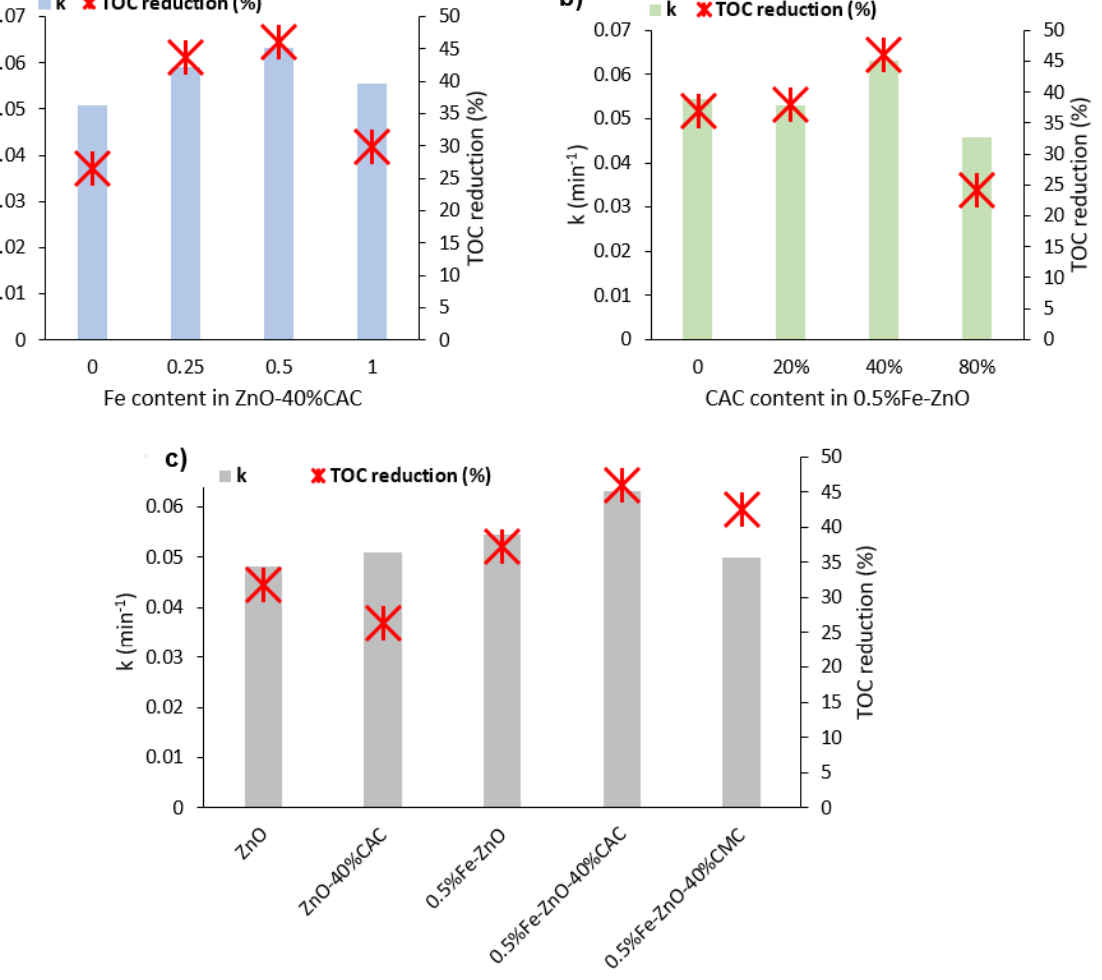
Figure 8. Comparison of degradation rate and mineralization of ibuprofen in the presence of different types of photocatalyst depending on ( a ) the Fe content in ZnO-40%CAC, ( b ) CAC content in 0.5%Fe-ZnO, ( c ) modification by 0.5%Fe and/or 40%CAC or 40%CMC of ZnO. Experimental conditions: IBU initial conc.: 20 mg dm − 3 , V = 15 cm 3 , photocatalyst: 0.5 g dm − 3 , irradiation time = 120 min.